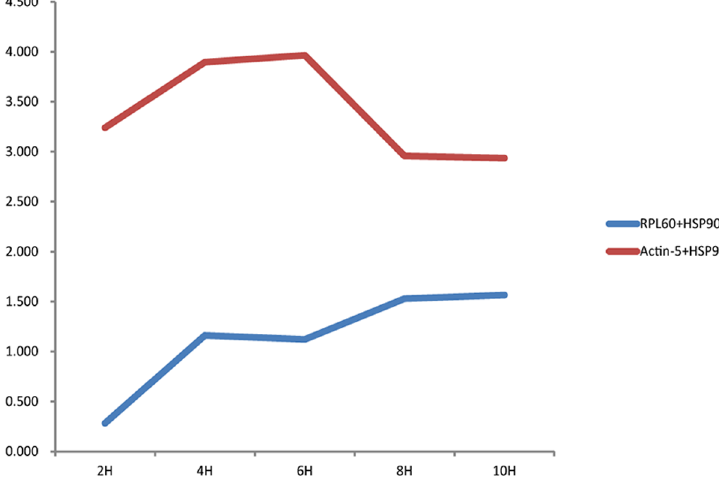
Fig 6. Expression of RPL60 and actin-5 under high-temperature treatment. Note: X-axis: time; Y-axis: relative quantification.